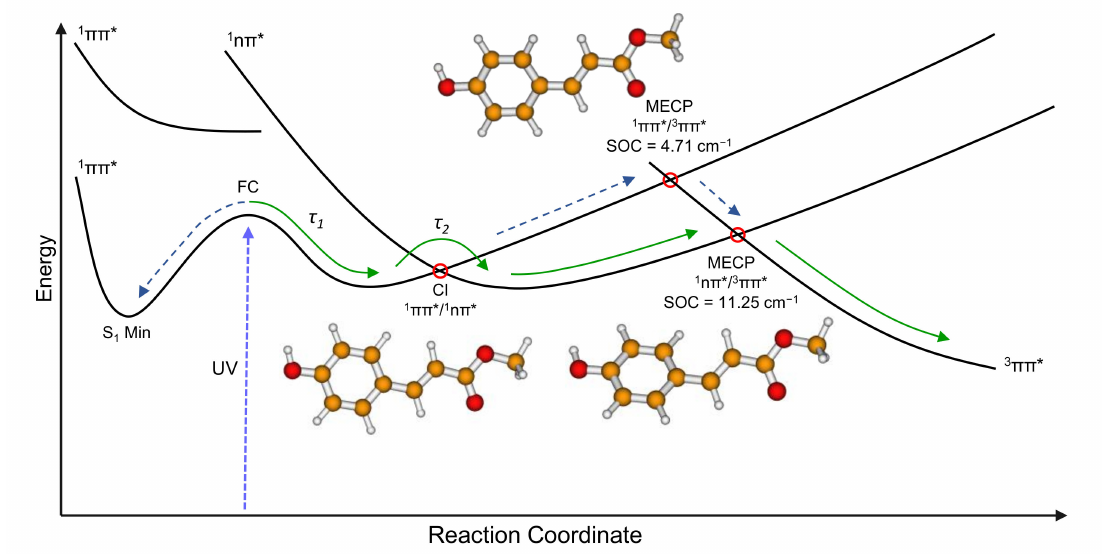
Figure 8. Potential energy surface schematic for s-cis OH-syn p-HMC, based on the energy landscape diagram in Figure 6. At the point of excitation, the vertical ordering of states is the first 1 ππ * state, the second 1 ππ * (not of dynamical interest) and the 1n π * state. The green arrows represent the major NRD route after photoexcitation to the first 1 ππ * state, while the dark blue dotted arrows represent alternative or competing excited state processes. The processes identified experimentally are labelled τ 1 and τ 2 and relate to the lifetimes measured in Section 2.1. CI and MECP structures are shown along with the relevant spin-orbit coupling (SOC)